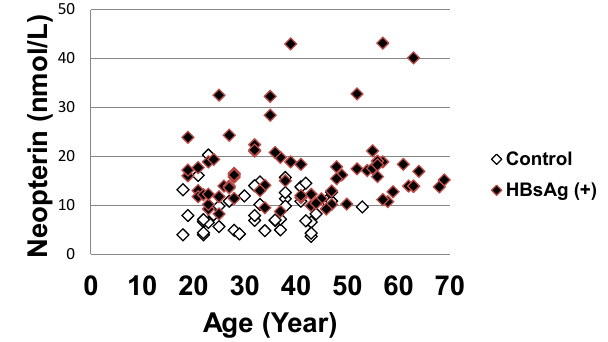
Figure 3: The distribution of neopterin concentrations according to the age.